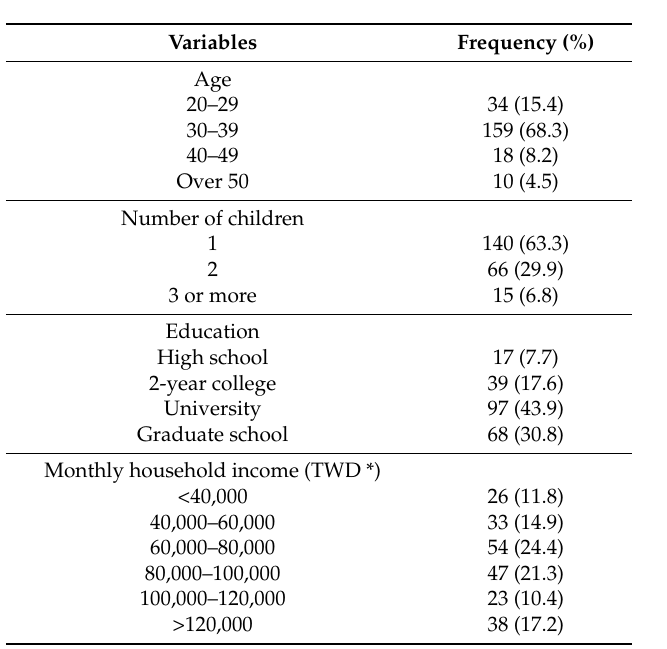
Table 1. Demographic information of study